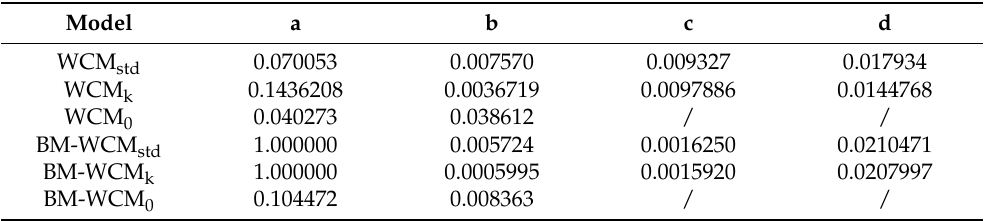
Table A2. Estimated parameters for the WCMs and BM-WCMs fitted using ALOS PALSAR-1 backscatter, CCI SM data, and field AGBC plot